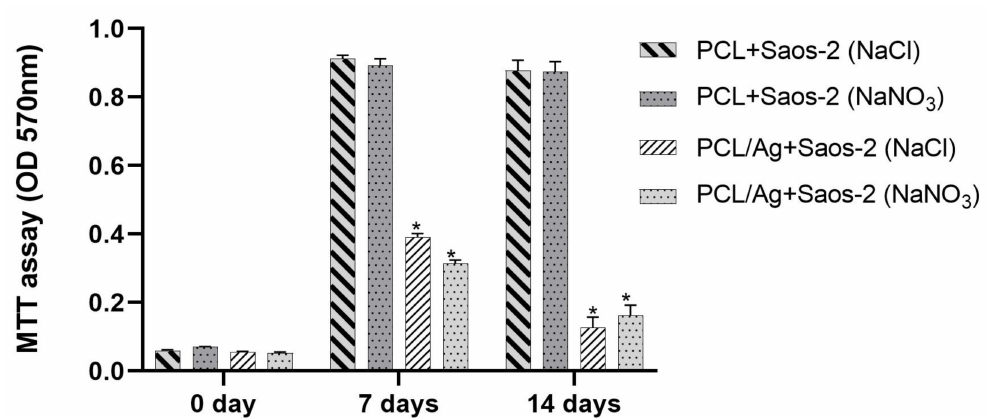
Figure 9. Cell viability (3-(4,5-Dimethylthiazol-2-yl)-2,5-Diphenyltetrazolium Bromide, MTT analysis) of sarcoma osteogenic- 2 (Saos-2) cells exposed to PCL-based biomaterial fabricated with NaCl or NaNO 3 salts and Ag-enriched, expressed an optical density (OD) at 570 nm. Results are the mean values ± SEM of at least three independent experiments; * p < 0.0001 unpaired t -test.